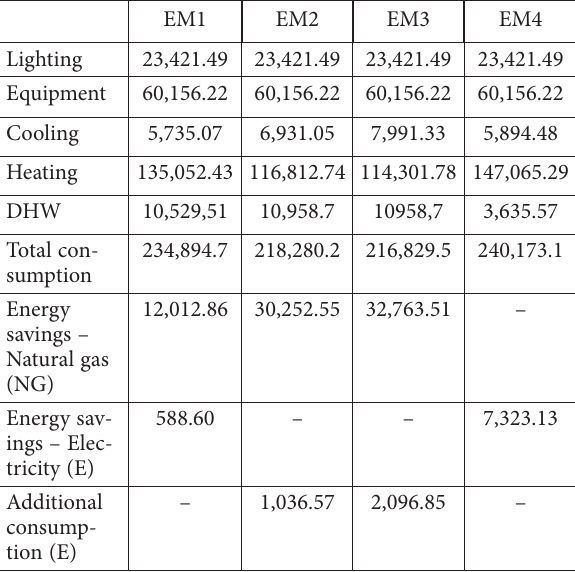
Table 6. Final energy consumption of the building with the efficiency measures EM1 to EM4